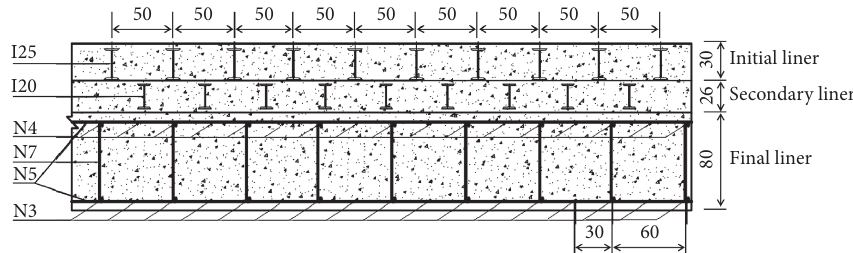
Figure 7: Design of liners of double-arch tunnels.